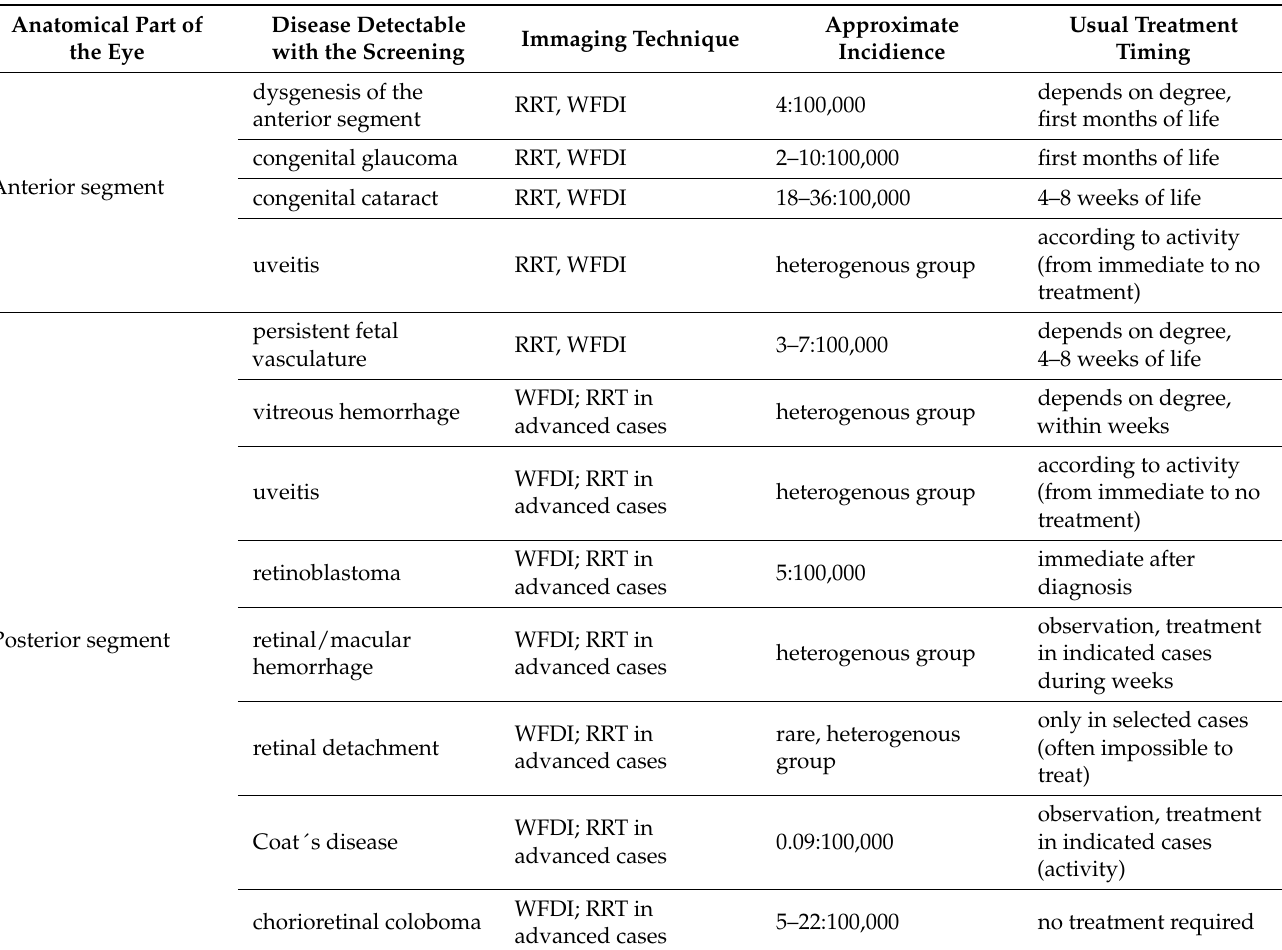
Table 1. Most common diseases detectable with the neonatal ophthalmic screening, approximate incidence and usual timing of